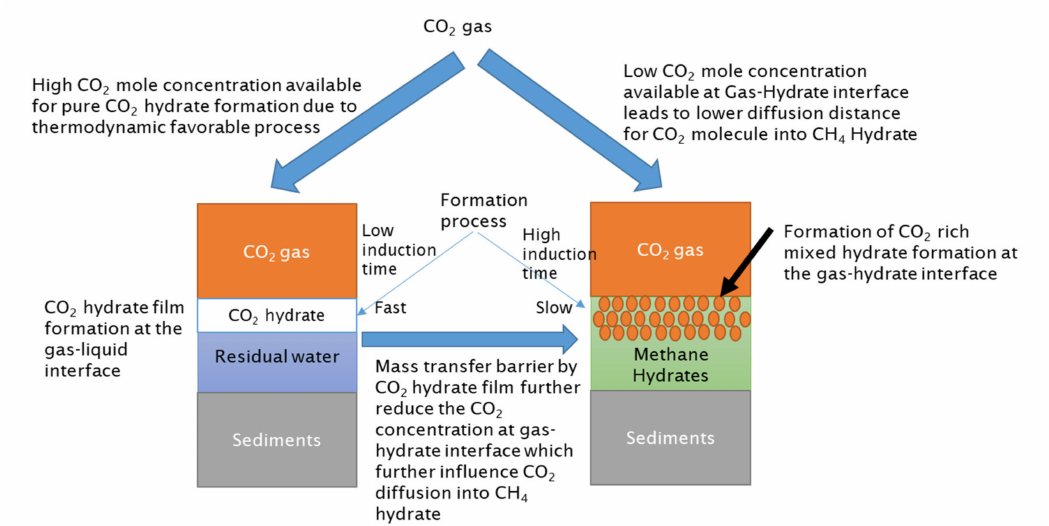
Figure 10. Hydrate formation mechanism at the gas–liquid interface and gas–hydrate interface and their relationship.